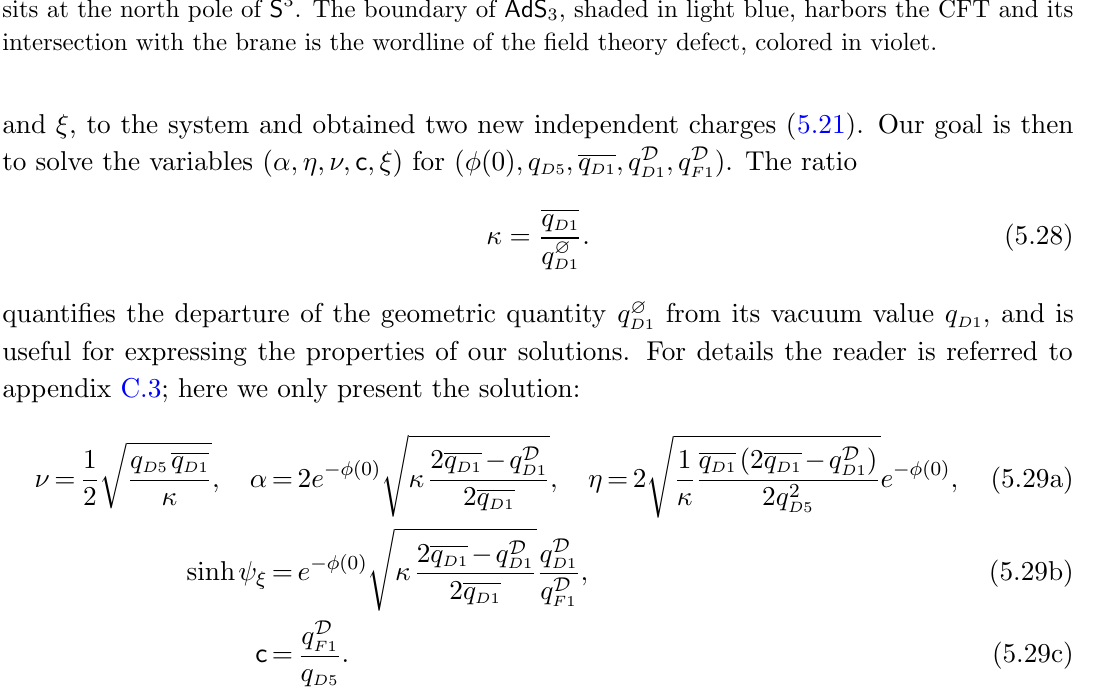
Figure 3 . In coordinates z = exp( + i(cid:18) ) AdS 3 is foliated by AdS 2 sheets shaded in dark blue and labelled by . A D1/F1 string, shaded in red, is embedded into AdS 3 (cid:2) S 3 at (cid:24) = exp (cid:24) , i.e.